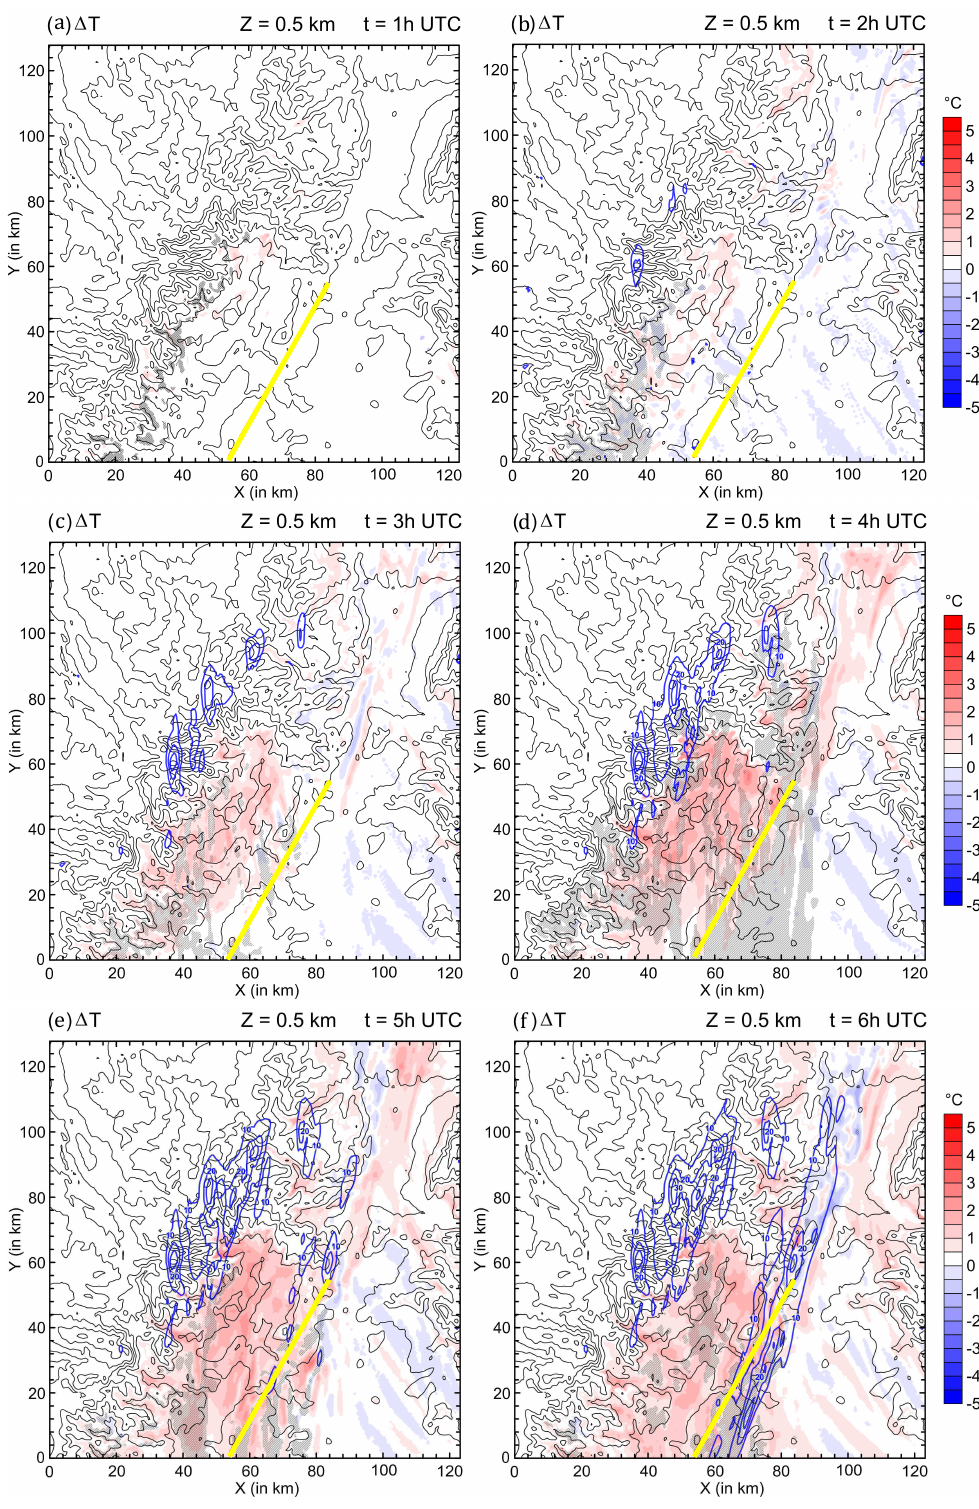
Figure 12. Hourly evolution of the temperature difference ( ∆ T ) between WRF-MORR and WRF-NOMIC at 0.5 km height from 01:00 to 06:00 UTC ( a – f ). The positive values indicates that the temperature is warmer in WRF-MORR than in WRF-NOMIC. The gray areas represent the zone where the cloud mixing ratio is greater than 0.001 g kg − 1 . The rain accumulation at the surface (in WRF-MORR) is represented from 10 mm every 10 mm by the solid blue lines. The yellow segment indicates the position of the wind convergence found at 07:00 UTC in the WRF simulations (see Figure